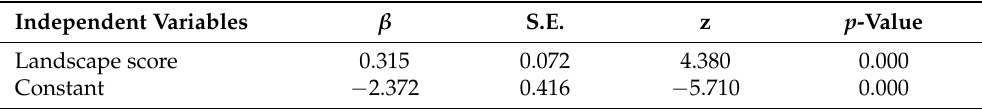
Table 7. Landscape score and probability that the participants are willing to pay more for one of the tasted juices. Dependent variable: HIGEST _ WTP (dummy indicating the highest WTP for each tasted pair).